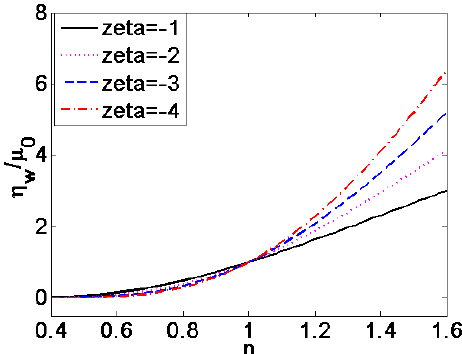
Figure 9. The variation of dimensionless dynamic viscosity at the channel wall generalized with the viscosity of Newtonian fluid µ 0 with flow behavior index n under the situation of different dimensionless zeta potential ξ ( K = 10).